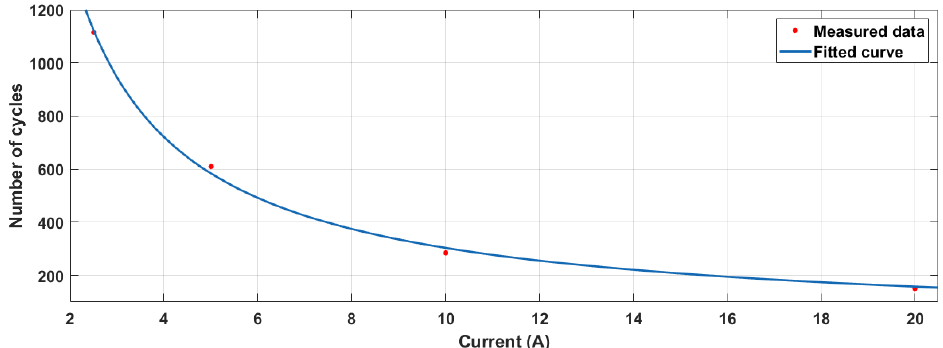
Figure 15. Influence of the discharge current on the maximal number of cycles before the battery cell reaches SoH = 80%.